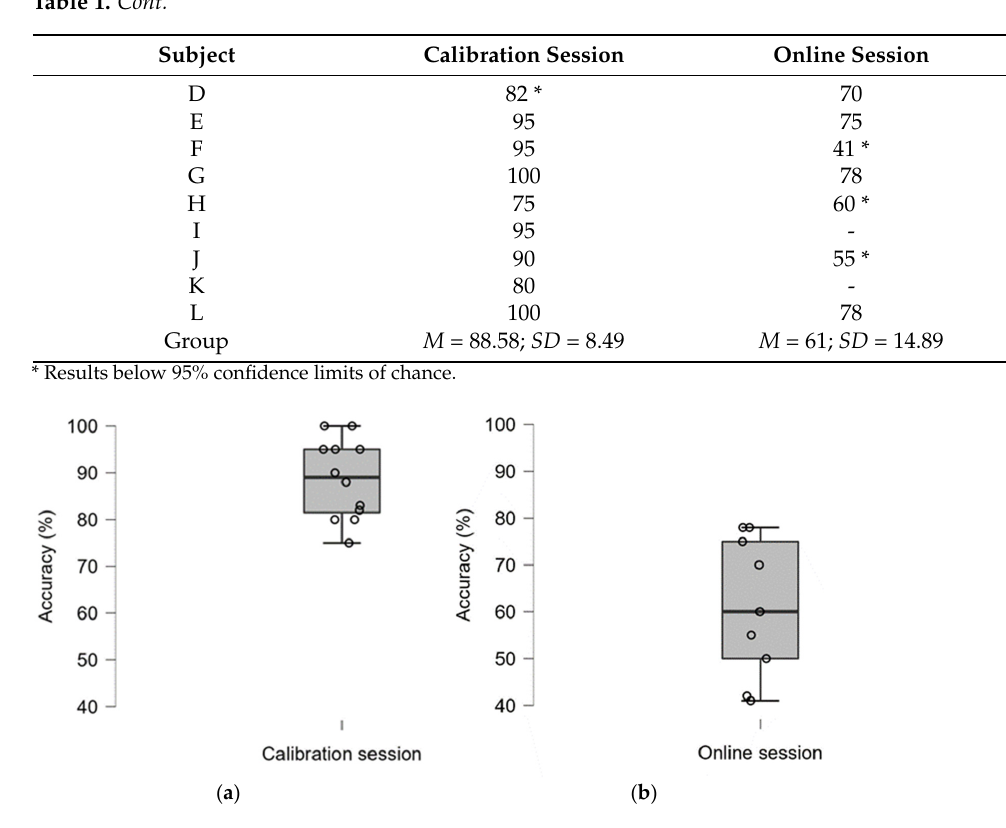
Table 1. Results of classification for individual participants ( n = 12).